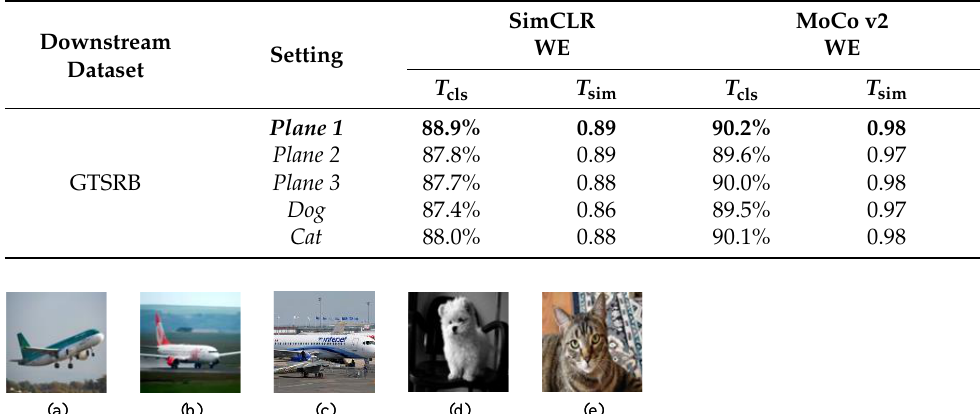
Table 3. Effectiveness valuation of different images as the key image.